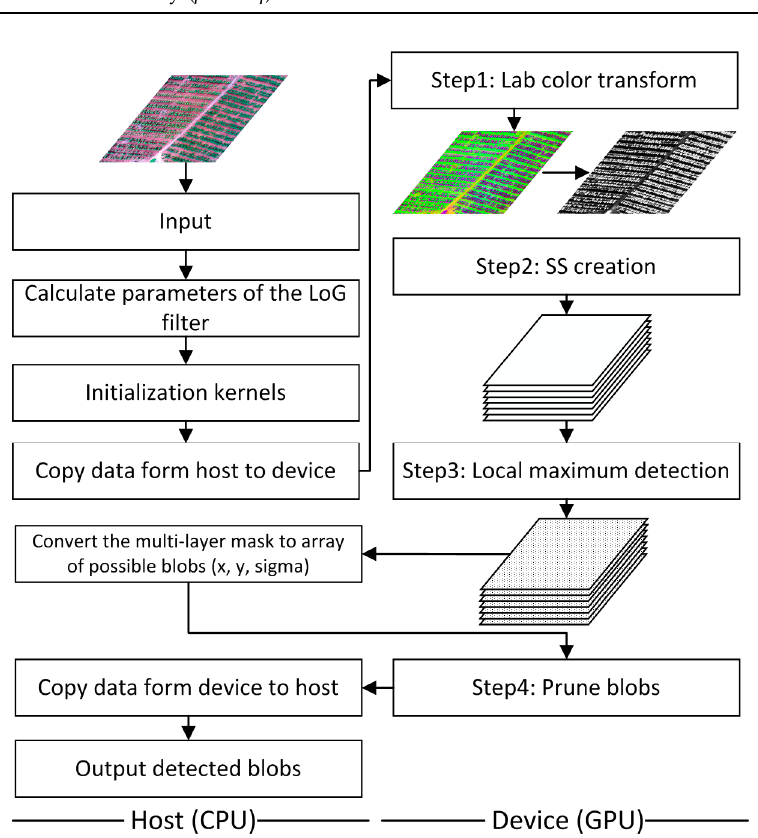
Figure 2. Summary of the tree detection method based on a parallel implementation of the scale-space (SS) filter.